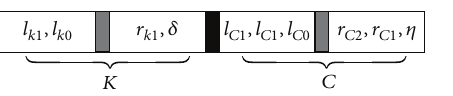
Figure 9: The structure of the decision variable 𝑋 with 10 parame- ters.